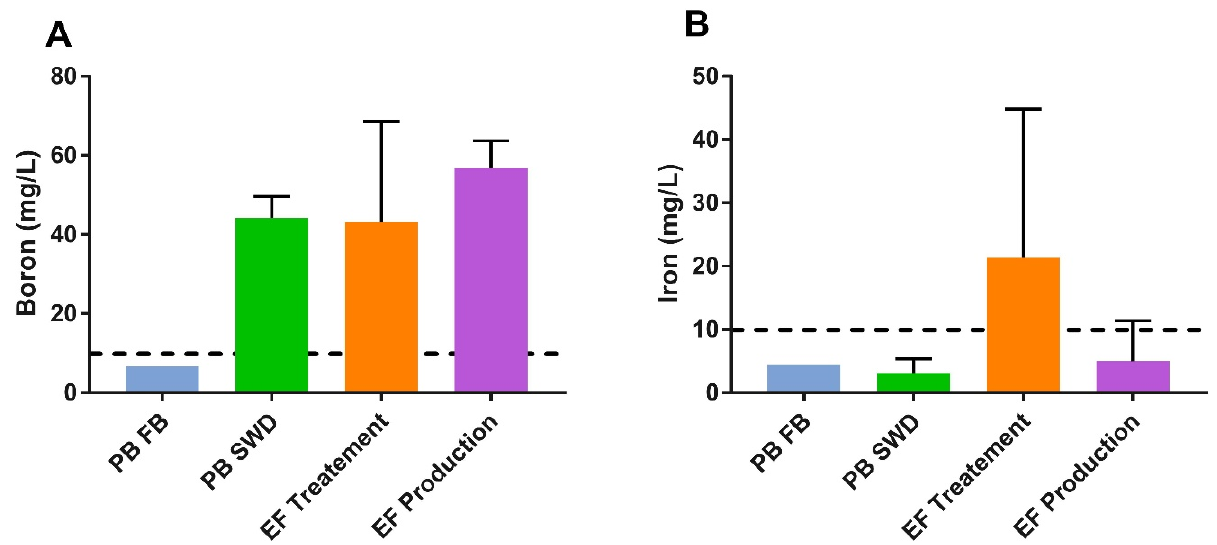
Figure 5. Boron ( A ) and iron ( B ) concentrations for the PW sample set. Data are presented as mean values with the error bars representing standard error of the mean. The reuse limits recommended by Hildenbrand, King, Oetjen, and Liden et al. are represented with black dotted lines [5,27–29].